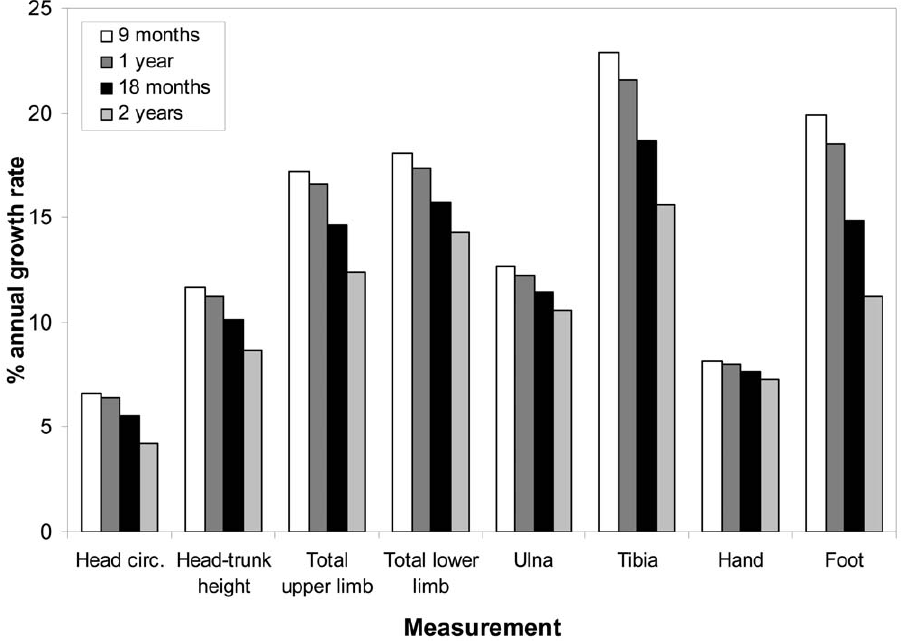
Figure 3. Cross-sectional estimate of percent annual growth rate of limb segments and head-trunk height by age. Growth rates calculated from LMS model median values for 3 months either side of age stated for female participants. ‘% annual growth rate’ refers to the estimated percentage increase in raw measurements over a year based on the median measurement at the start of the 6 month period over which the rate is calculated. Male data demonstrate the same pattern (not shown). Measurements are lengths, apart from ‘head circ.’ which is head circumference.